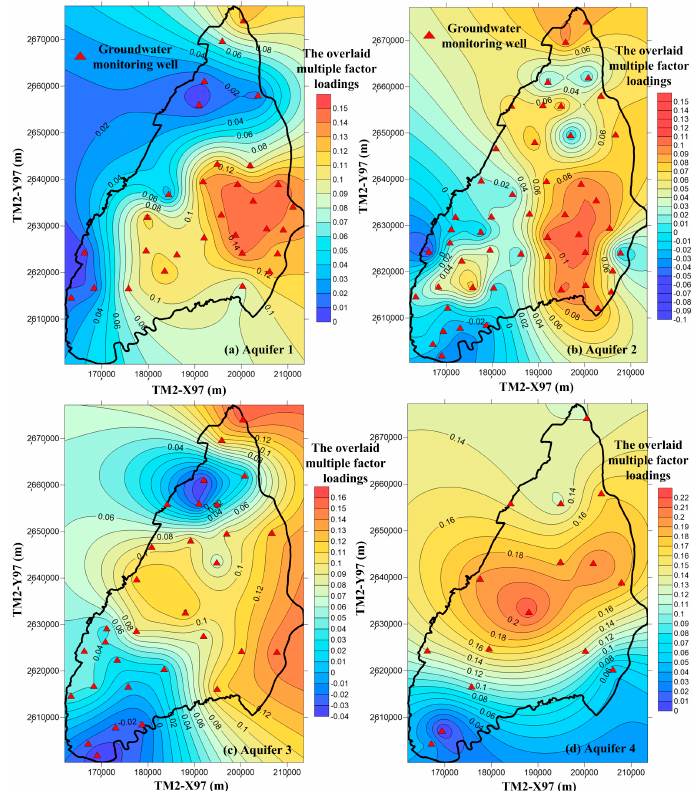
Figure 8. The overlaid factor loadings for an initial spatial estimate of surface/boundary recharge in Cho-Shui River alluvial fan: ( a ) Aquifer 1; ( b ) Aquifer 2; ( c ) Aquifer 3; ( d ) Aquifer 4.